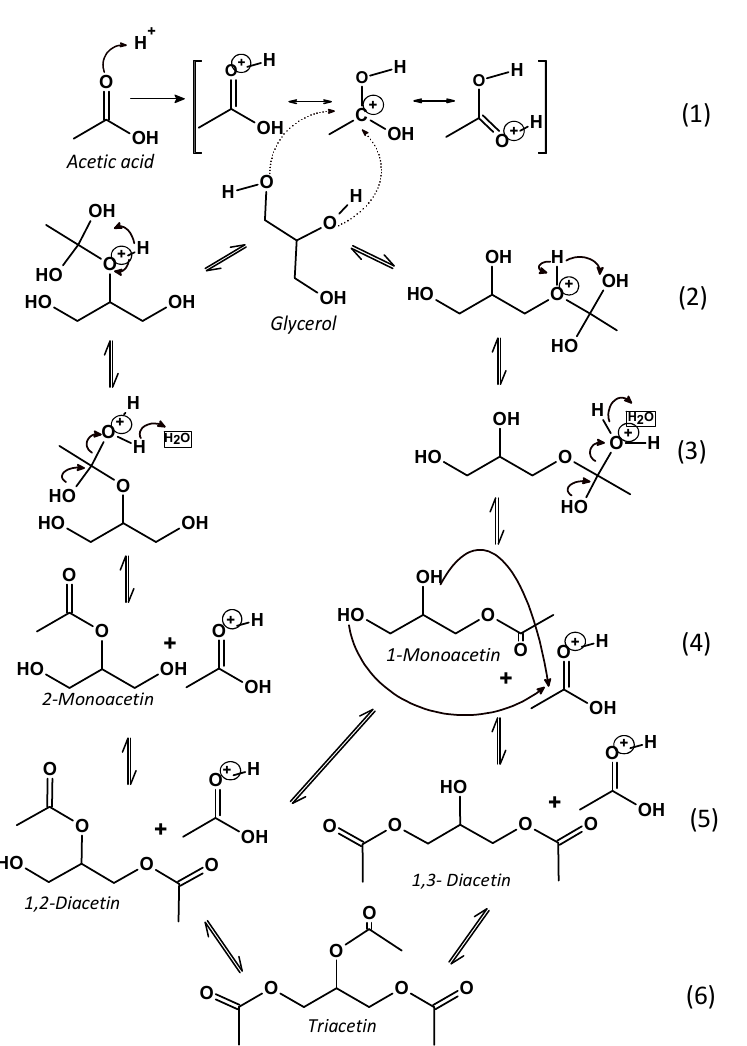
Figure 3. Illustration of the proposed mechanism for glycerol esterification with acetic acid reac- tion.